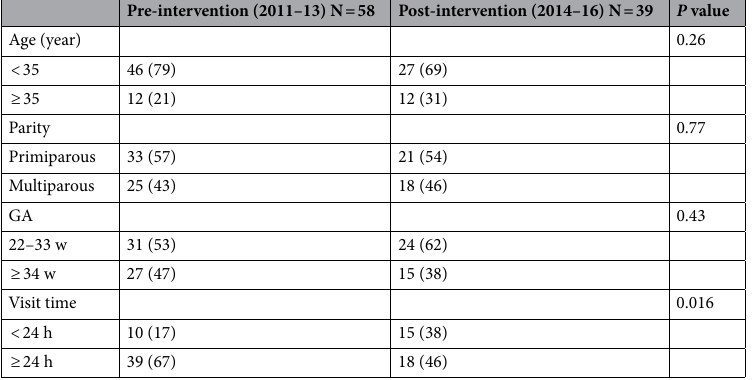
Post-intervention n =